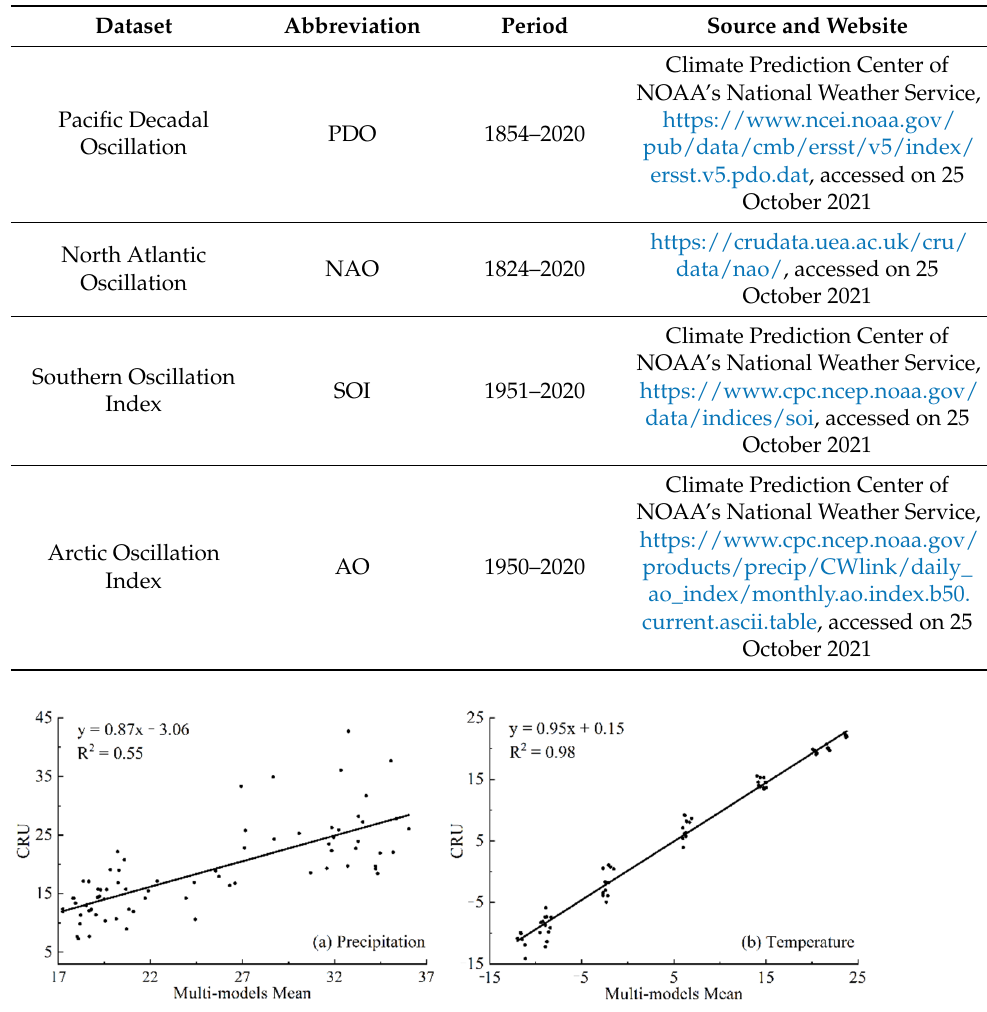
Table 1. Five major climatic indexes used in this study.